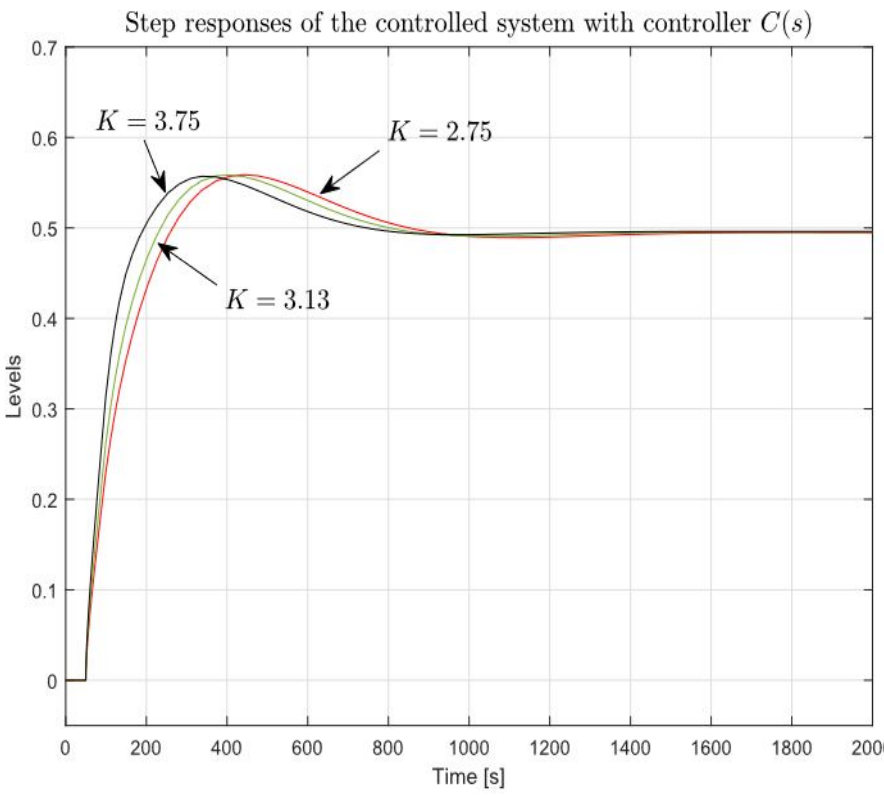
Figure 3. Different levels of step responses in isodamping of a control system [50].